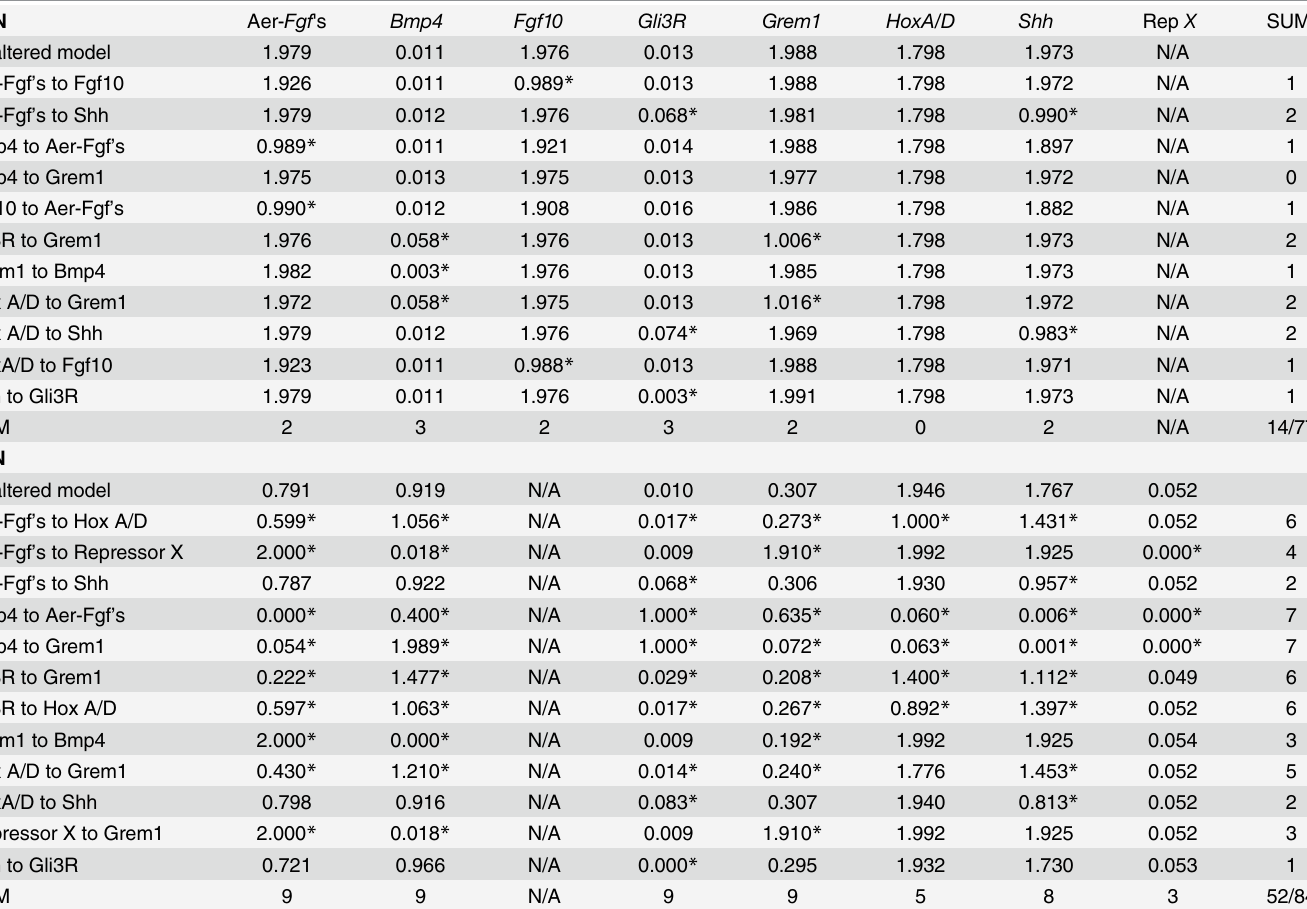
Table 1. Effects of removals of gene-to-gene interactions in simulations on gene expression level. Asterisks indicate values that differ more than 10% from values generated by the unaltered model. The total number of values that differ more than 10% are shown in the last column and row. In total, 14 of 77 (18%) possible expression levels are affected by alterations in the ESN, while 52 of 84 (62%) possible expression levels are affected by alterations in the LSN. ESN